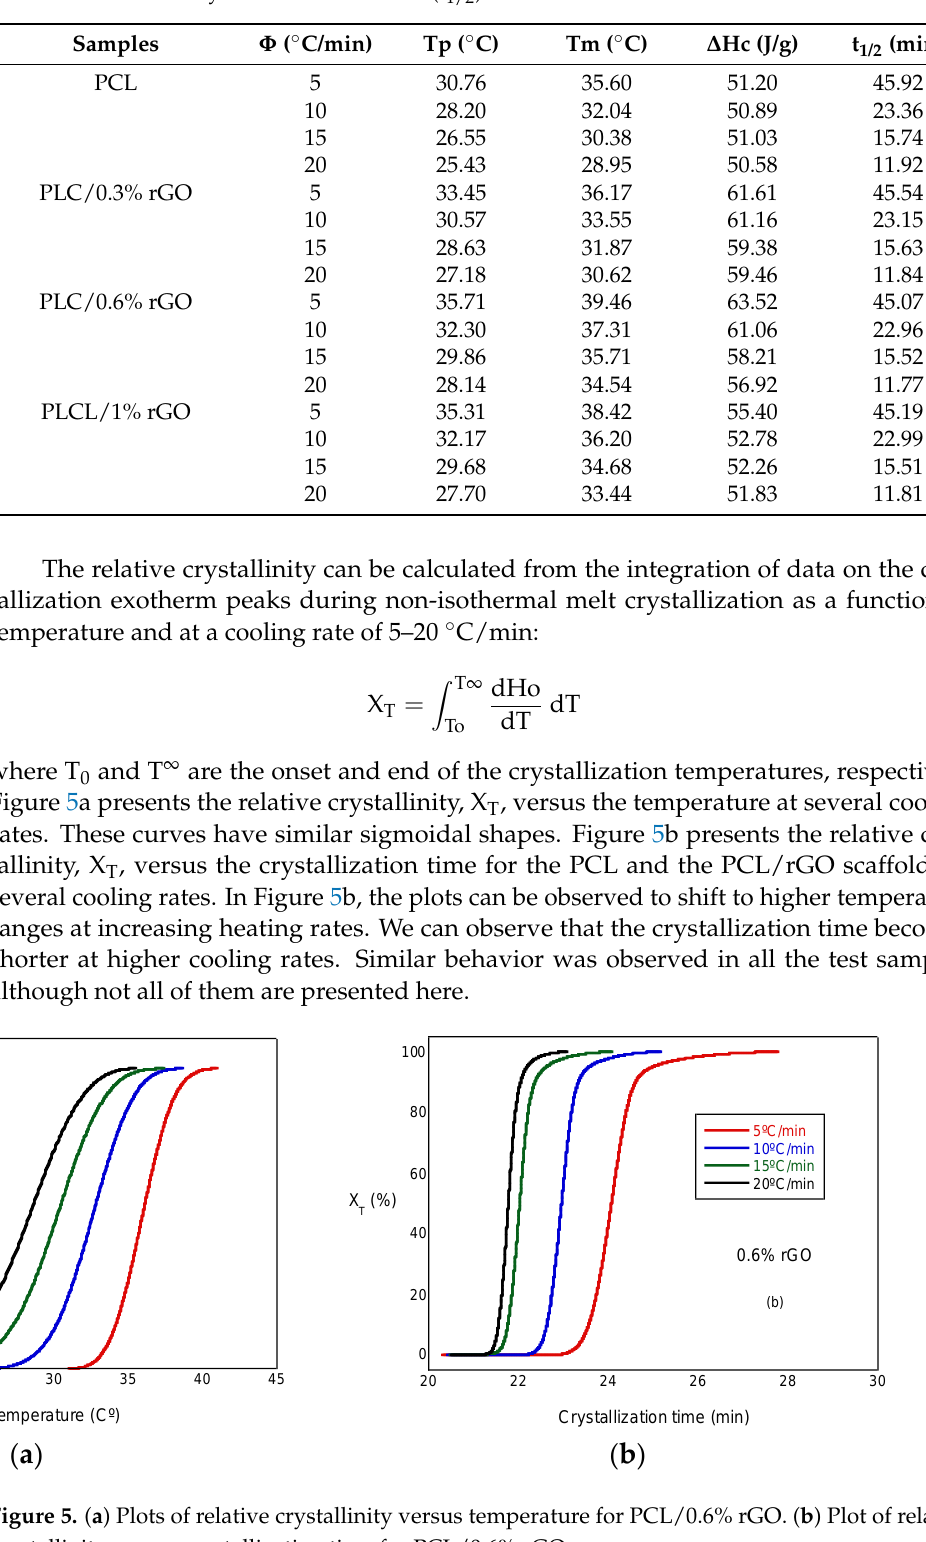
Table 2. Summary of relevant thermal parameters for neat PCL and its nanocomposites: heating rate ( Φ ), non-isothermal peak temperature (Tp), melting temperature (T m ), crystallization enthalpy ( Δ Hc) and non-isothermal crystallization half-time (t 1/2 ).